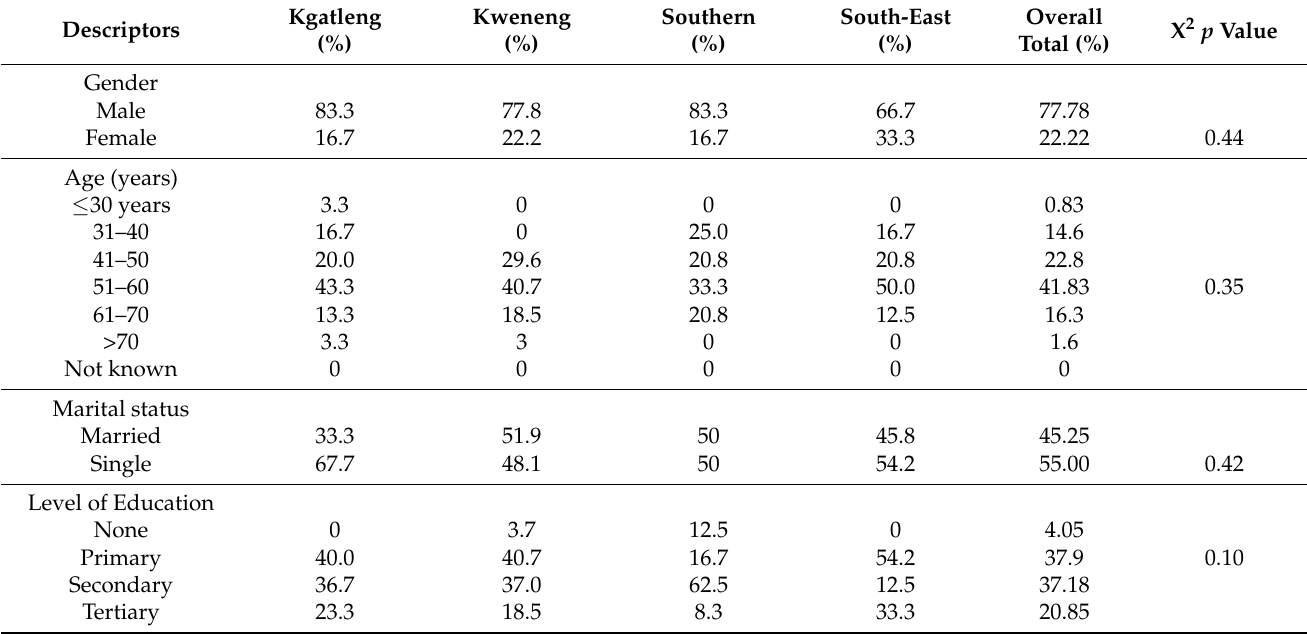
Table 1. Socio-economic characteristics of households (%) keeping sheep in the four regions of